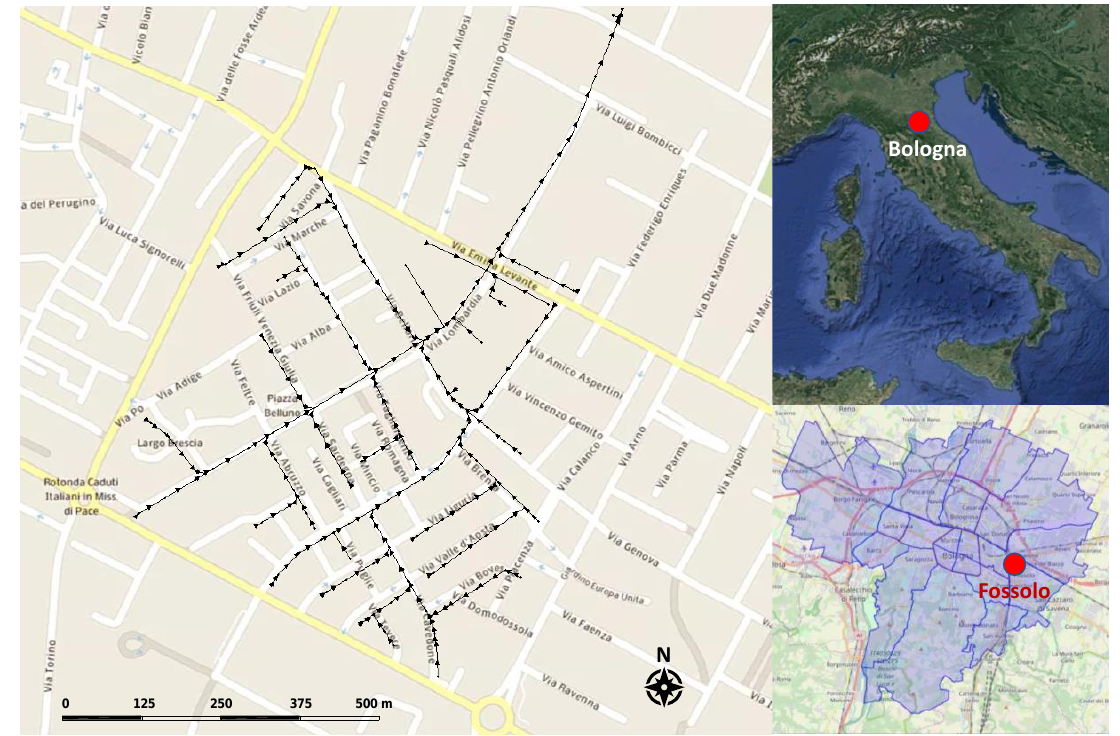
Figure 1. Catchment boundary and sewer layout for the pilot urban catchment.